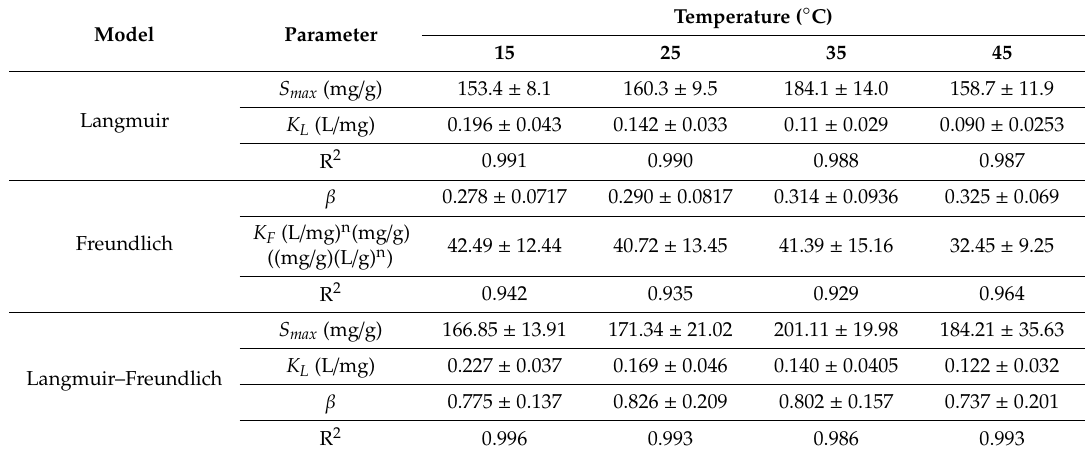
Table 2. Optimal estimates and 95% confidence intervals of isotherm parameters for MB adsorption onto BP.